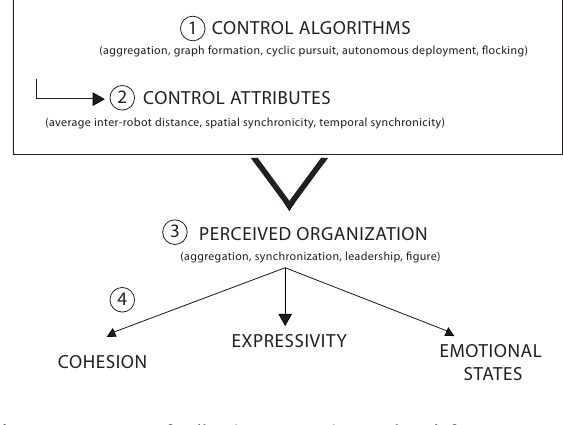
Figure 1: Structure of collective expression explored: from swarm control algorithms (1), we extract common control attributes (2) in order to assess the swarm perceived organisation elements (3) and finally relate these elements to cohesion, expressivity and emotional states (4) of the